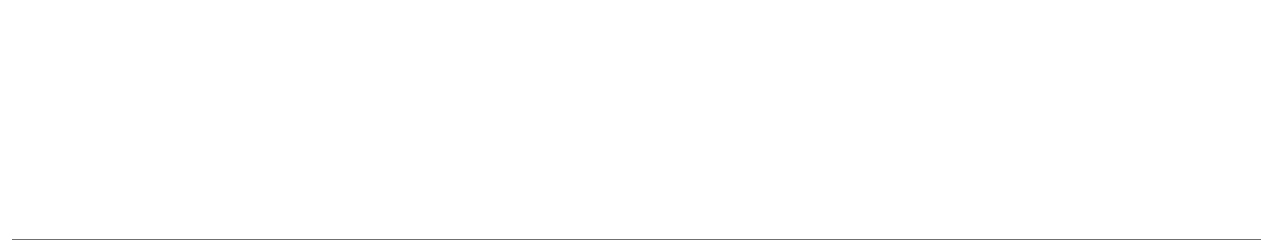
Frontiers in Physics |